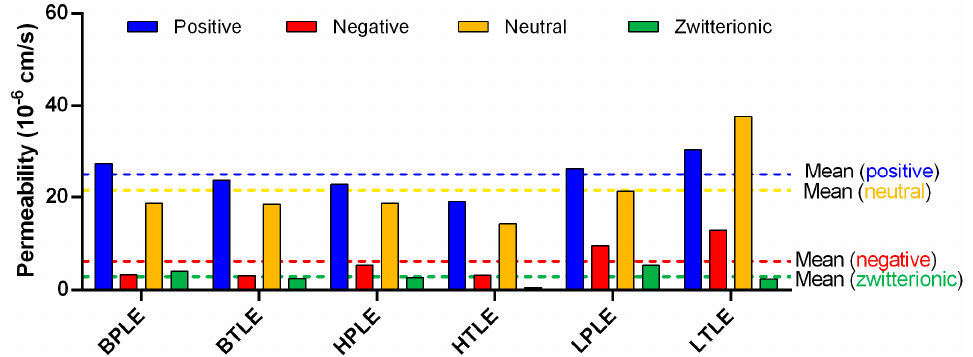
Figure 8. Permeability of 32 drugs on tissue-specific membranes based on charge state at pH 7.4. All permeability data represent the mean of three replicates. Mean values are marked with scattered lines. BTLE—brain total lipid extract, LPLE—liver polar lipid extract, HTLE—heart total lipid extract, BPLE—brain polar lipid extract, LTLE—liver total lipid extract, and HPLE—heart polar lipid extract.